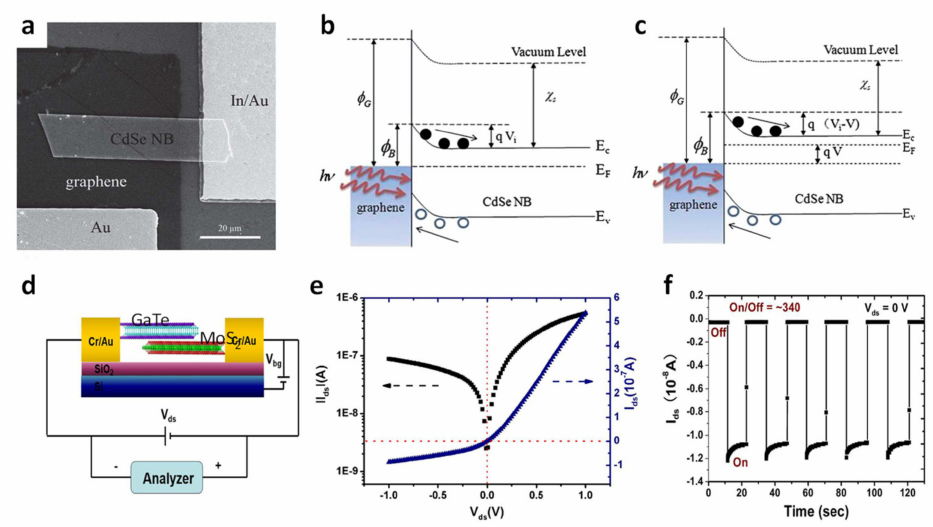
Figure 2. ( a ) FESEM image of a photodetector; ( b , c ) are energy band diagrams for the photodetector under external light irradiation of short circuit and load, respectively. Φ G is the work function of graphene, Φ B is the Schottky barrier height, V i is the built-in potential, V is the voltage drop of the resistor, E C is the conduction band edge, E V is the valence band, and E F is the Fermi level [61]. Re- produced with permission from [61]. Copyright 2012, Royal Society of Chemistry. ( d ) A schematic of a GaTe-MoS 2 heterostructure phototransistor. ( e ) Current-voltage curve of the device (Vds = − 1~1 V, V bg = 0 V). ( f ) Self-driven photo-switch behavior of the GaTe-MoS 2 heterostructure photodetector (V ds = 0 V) [62]. Reproduced with permission from [62], Copyright 2016, American Chemical